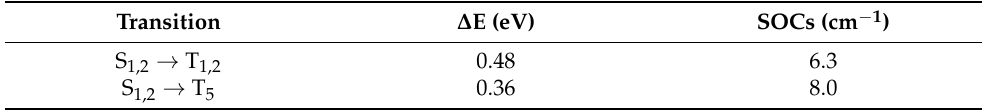
Table 2. Energy gaps between the calculated excited singlet and triplet states and their corre- sponding spin–orbit couplings obtained for microsolvated CA at the